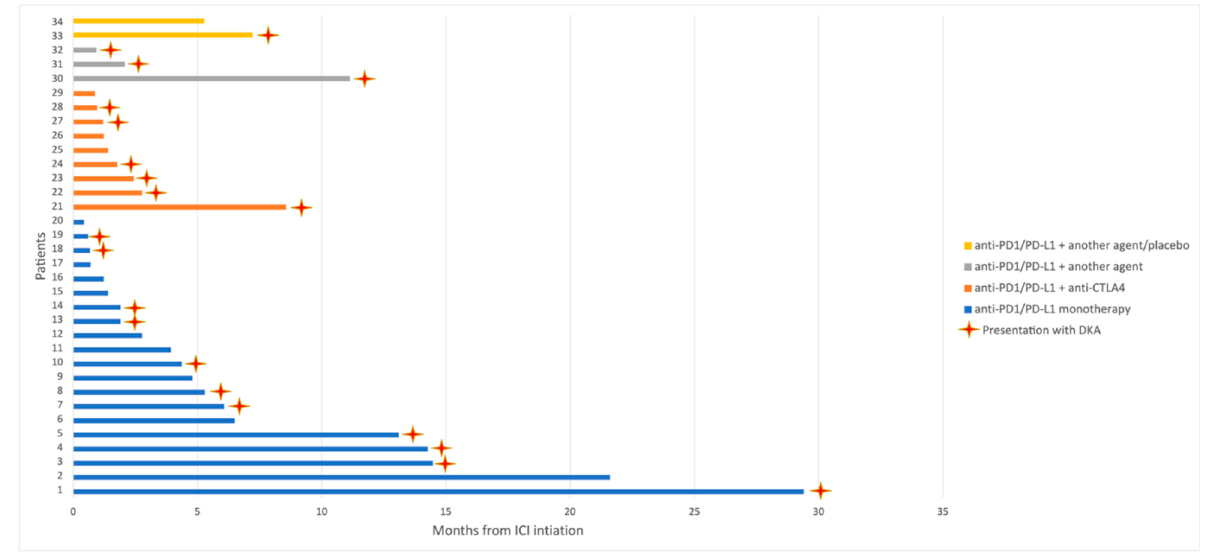
Figure 1. Time to onset of ICI-induced IDDM in 34 patients. Patients are grouped according to ICI treatment modality. CTLA4: cytotoxic T lymphocyte antigen 4; DKA: diabetic ketoacidosis; ICI: immune checkpoint inhibitor; IDDM: insulin-dependent diabetes mellitus; PD1: programmed death 1; PD-L1: programmed death ligand 1.